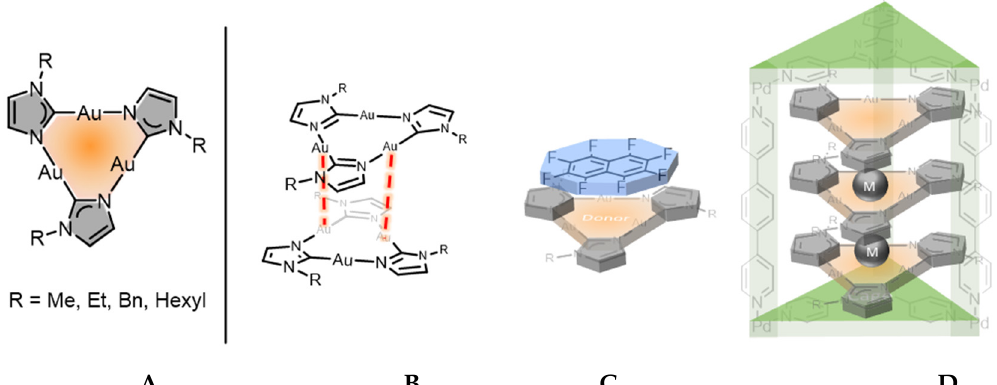
Figure 1. ( A ) General structure of imidazolate-based CTCs [Au 3 (MeIm)] 3 [7,20]; [Au 3 (EtIm)] 3 [3]; Au 3 (BzIm) 3 [19]; Au 3 (HexIm) 3 [18]; ( B ) illustration of possible metallophilic interaction (red dashed lines); ( C ) an example of π electron lewis acid/base binding model [18]; ( D ) guest supramolecular trigonal prismatic arrays within a Pd(II) coordination cage host, M = Ag + cation [14].